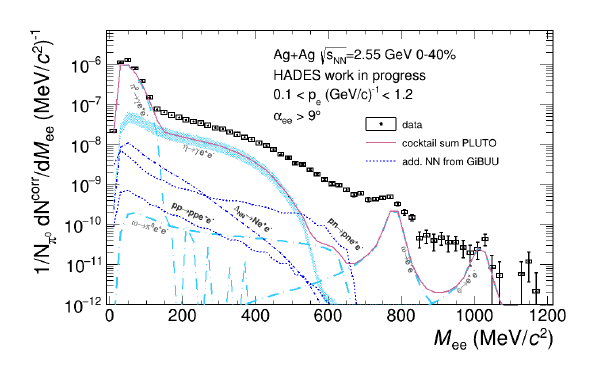
Figure 4. Decomposition of the measured dielectron signal (compare fig. 3) into its contributions from the di ff erent stages of the heavy-ion collision. PLUTO [10] simulations are used to address the freeze- out hadron contribution while the transport model GiBUU [11] is used to model dielectron production in the initial NN